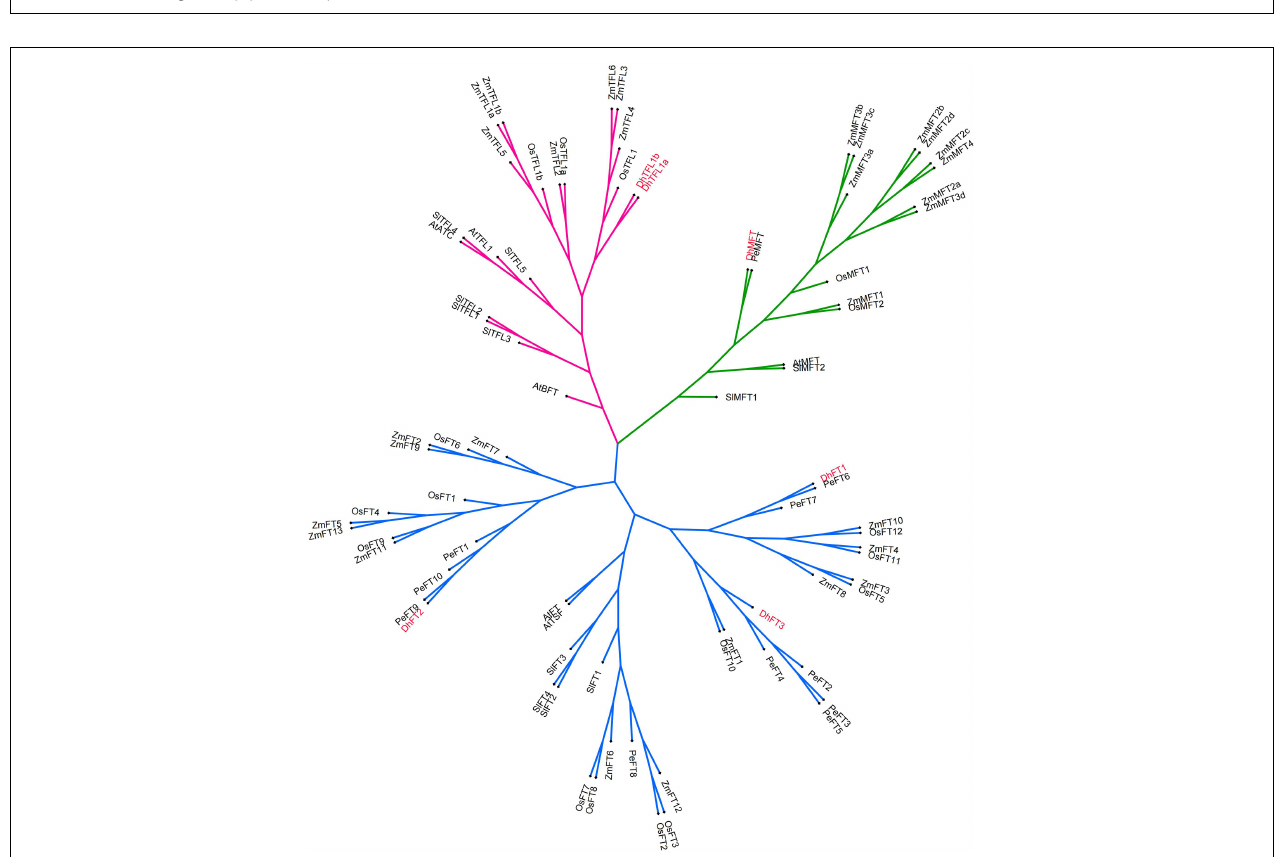
FIGURE 3 | The gene structure and the conserved motif of PEBP genes in D. huoshanense. (A) The gene structure of exon and intron. (B) The conserved motif distributed in PEBP genes. (C) The composition of three main motifs.